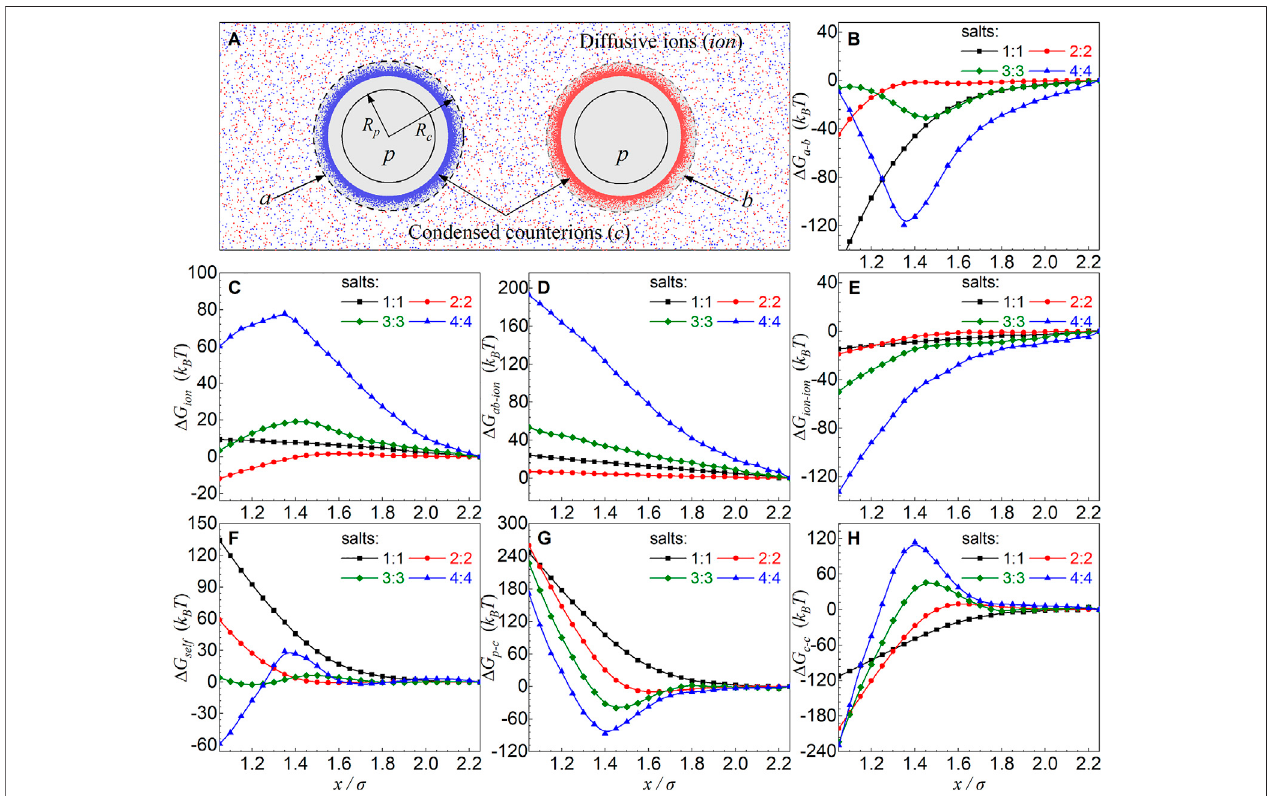
FIGURE 6 | (A) An illustration for two oppositely charged particles in z : z salt solutions for analyzing in detail the different contributions to electrostatic energy: interactionenergy Δ G a-b betweentwooppositelychargedparticleswiththeirrespectivecondensed counterionsdenotedby “ a ” and “ b ” (theshadedregions),interaction energyassociated with diffusive ions Δ G ion including the interaction energy Δ G ion-ion between diffusive ions and interaction energy Δ G ab-ion between condensed shells ( a and b ) and diffusive ions, and the interaction energy Δ G self within the condensed shells ( a and b ) including the interaction energy Δ G c-c between condensed counterions and interaction energy Δ G p-c between particles and their condensed counterions. Here, “ c ” denotes the condensed counterions and “ ion ” denotes the diffusiveions. (B – H) Δ G a-b (B) , Δ G ion (C) , Δ G ab-ion (D) , Δ G ion-ion (E) , Δ G self (F) , Δ G p-c (G) ,and Δ G c-c (H) asfunctions ofthe separation x betweentwo oppositely charged particles in z : z salt solutions. The salt concentrations are 0.3 M, and the particle charge is |Z| (cid:1) 36 e